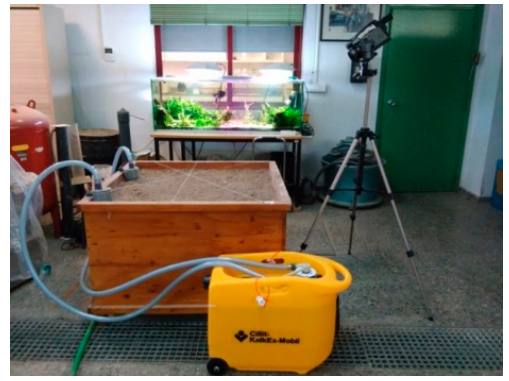
Figure 1. The laboratory model working with the Thermographic camera.